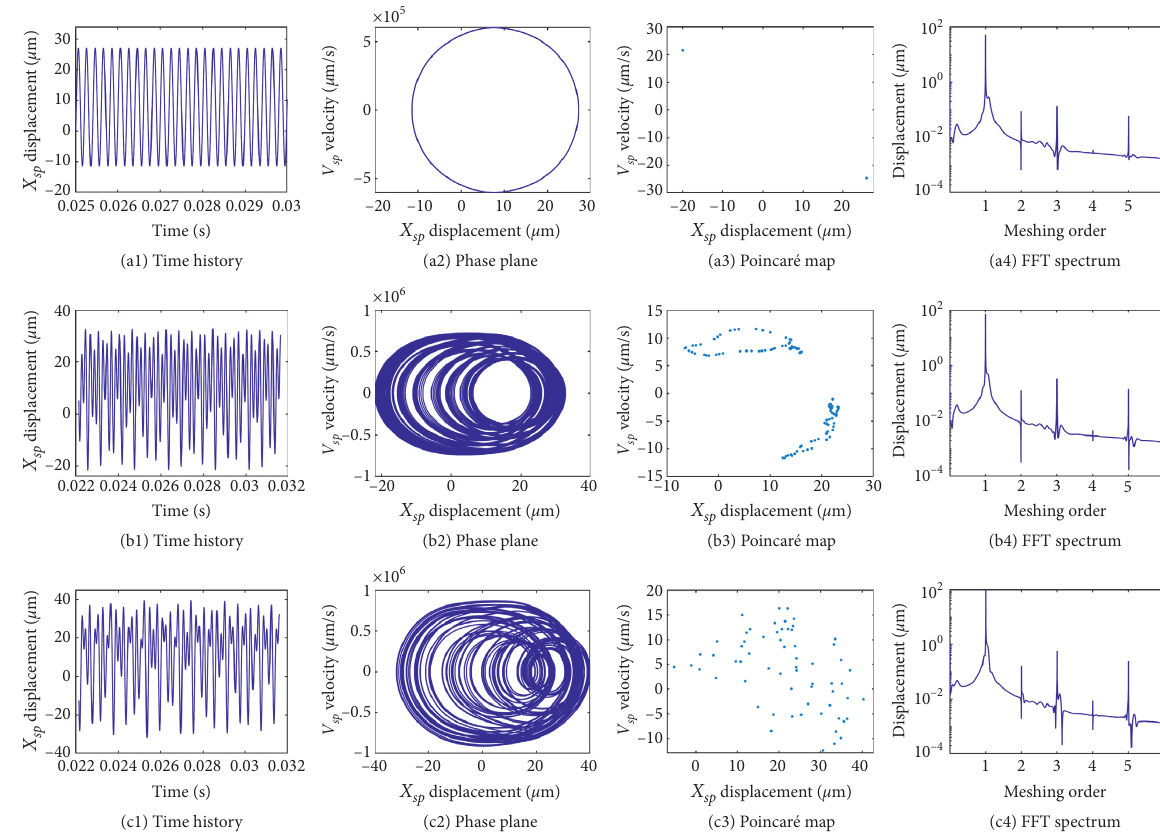
Figure 8: Vibration response of sun gear and star gear meshing pair. (a) b � 3, (b) b � 7, (c) b �